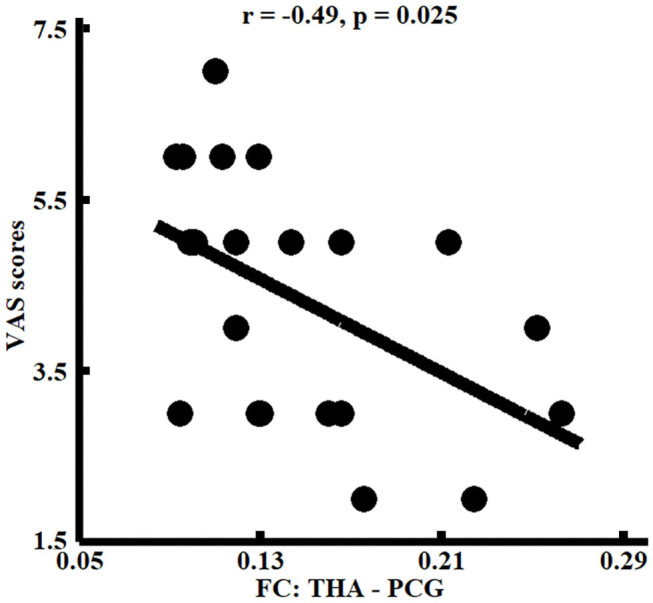
Correlation analyses between whole brain functional connectivity homogeneity (FcHo) and functional connectivities parameters and clinical performances. Significant correlation between the functional connectivities of THA with PCG and pain intensity (i.e., VAS scores) was identified in patients with migraine without aura.